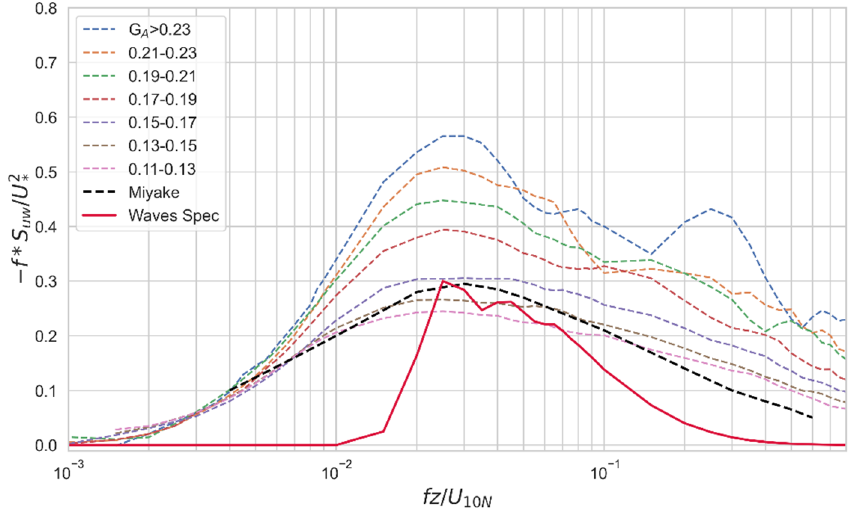
Figure 13. Observed u (cid:48) w (cid:48) cospectra S uw normalized using the universal scaling of Miyake, Stewart,